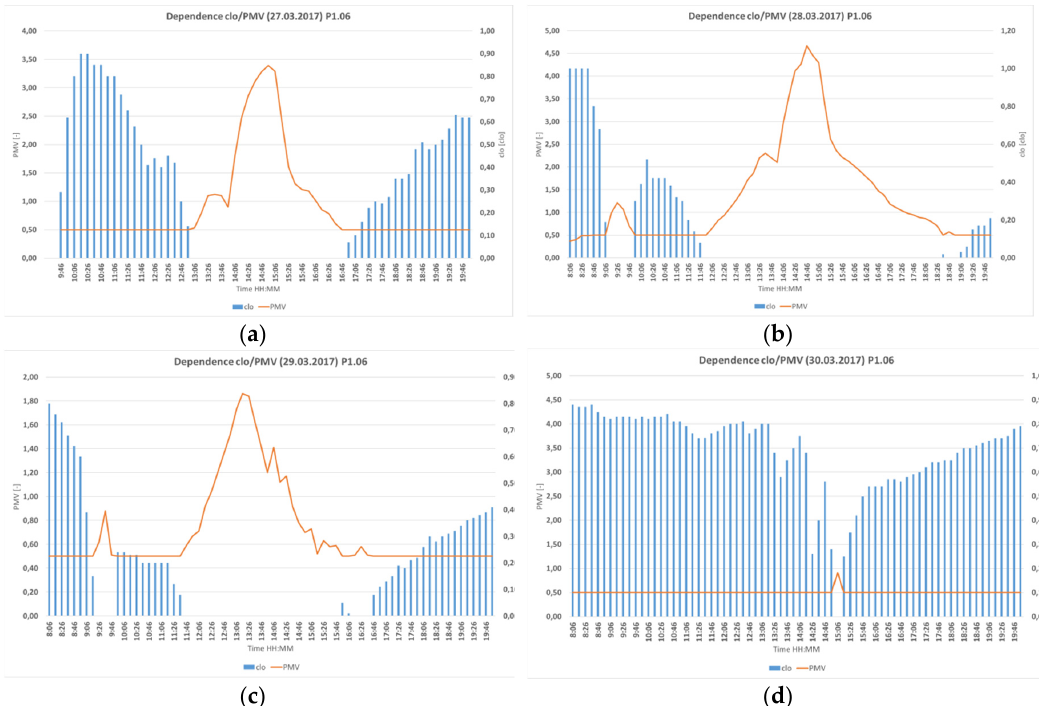
Figure 17. ( a ) PMV relationship (assumed value: +0.5 [-]) P1.06. (27.03.2017); ( b ) P1.06. (28.03.2017); ( c ) P1.06. (29.03.2017); ( d ) P1.06. (30.03.2017).